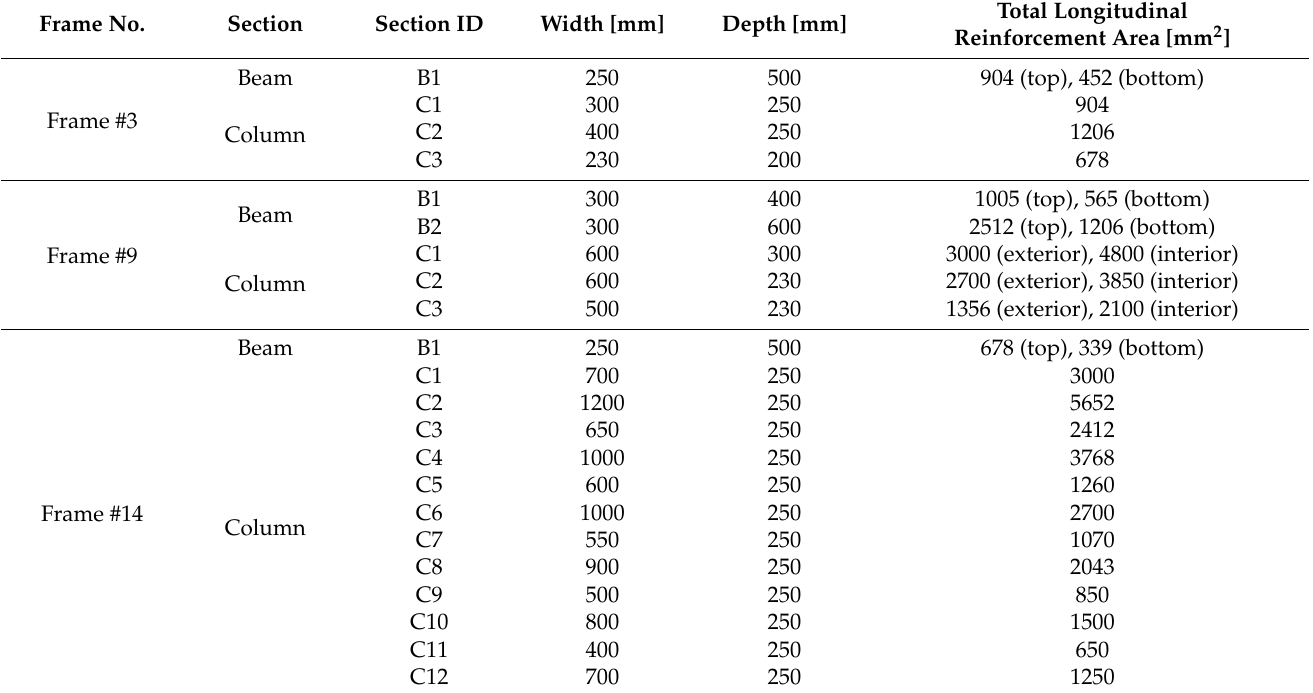
Table 3. Sectional properties of Frames #3, #9 and #14 in Table 2.